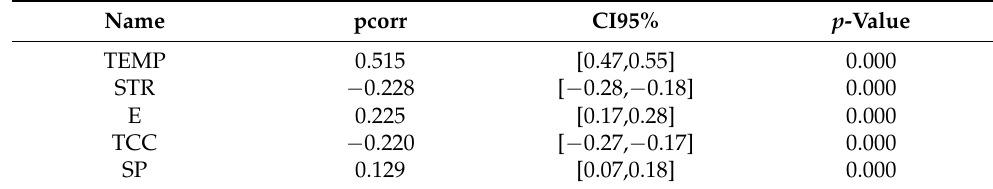
Table 8. The partial correlation coefficient between climate variables and LSWT of Qinghai Lake ( p -value <